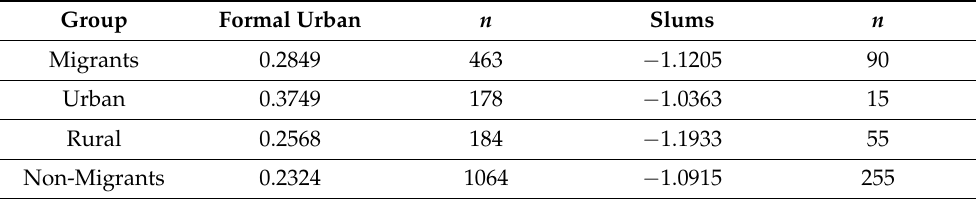
Table 2. RCI of migrants (urban, rural origin) and